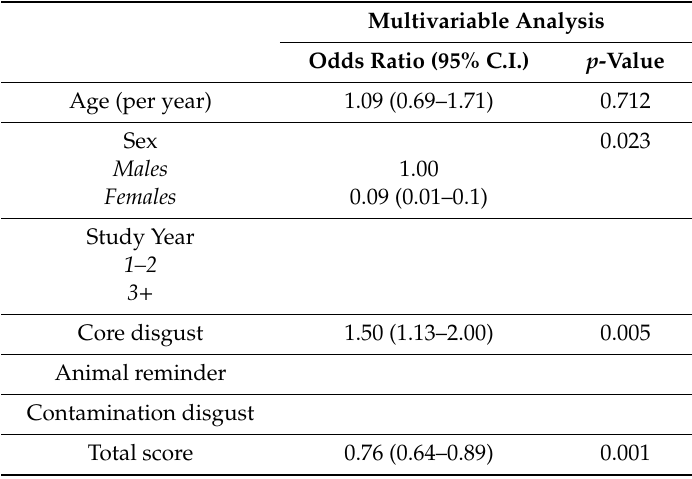
Table 5. Odd ratios (OR) and corresponding 95% confidence intervals (95% CI) of univariate logistic regression for the selection of experimental psychology ( n = 97 psychology